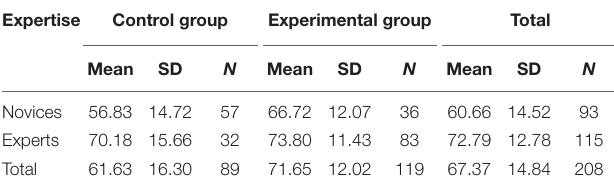
TABLE 2 | Descriptive statistics of pre-service teachers’ performance on the